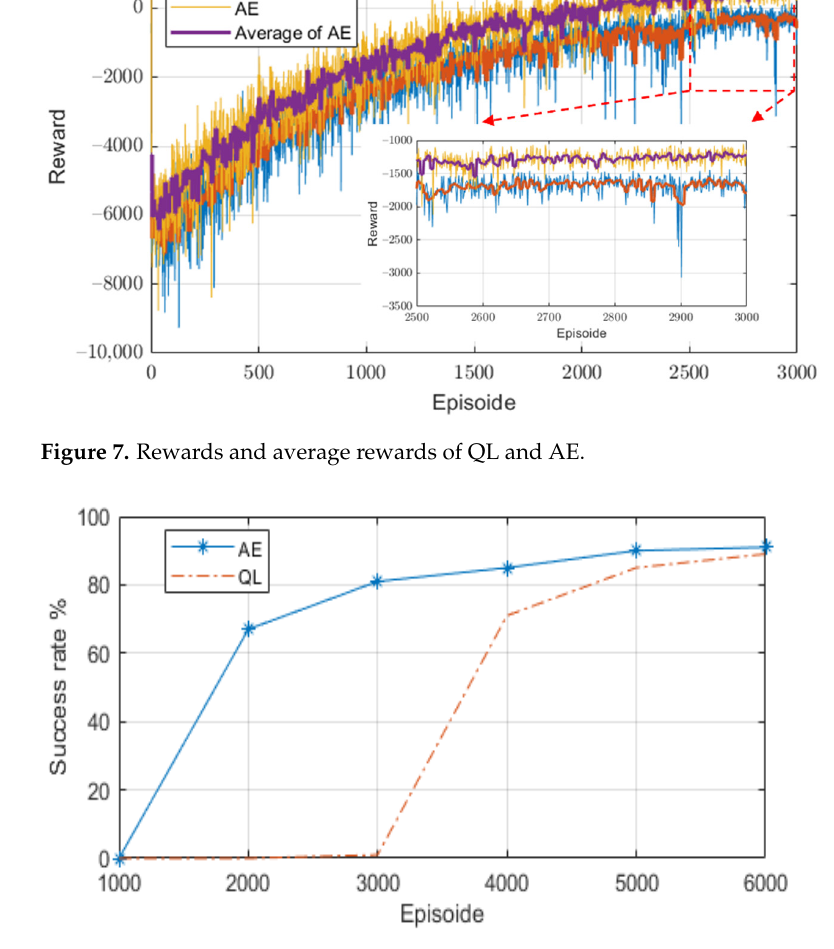
Figure 8. Rewards and average rewards of QL and AE.